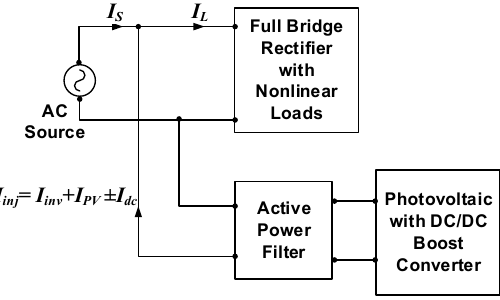
Figure 1. Block diagram of Photovoltaic Shunt Active Power Filter (PV SAPF).